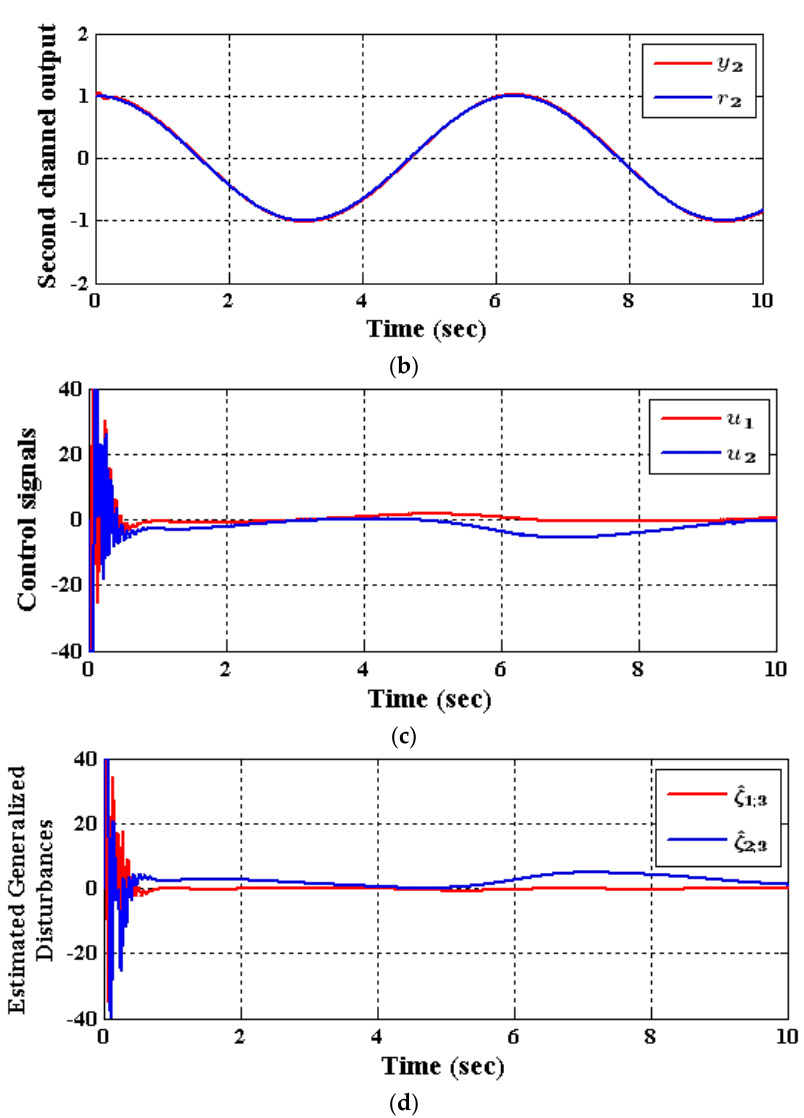
Figure 10. The output response of Equation (42) using CADRC, ( a ) output y 1 , ( b ) output y 2 , ( c ) control signals u 1 and u 2 , and ( d ) estimated generalized disturbances ˆ ξ 1,3 and ˆ ξ 2,3 .